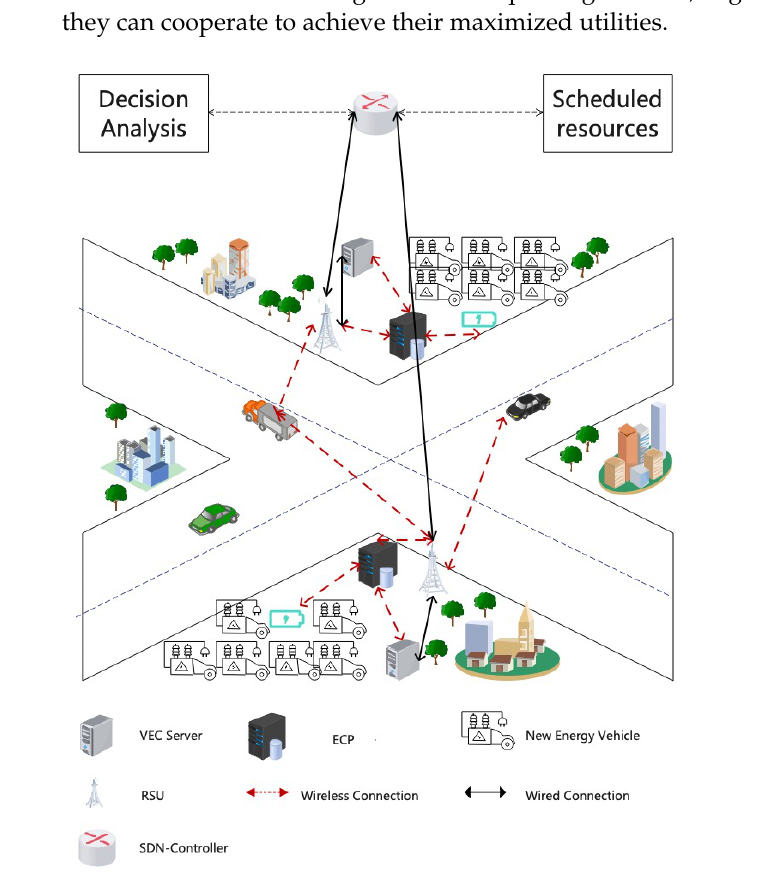
Figure 1. The SDN-based VEC